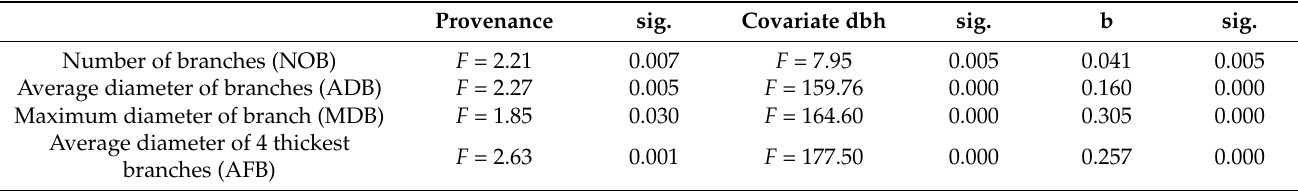
Table 3. Results of the ANCOVA test. F -values and significance level are shown for provenance as a main factor and dbh as a covariate (b-value and its significance refers to the